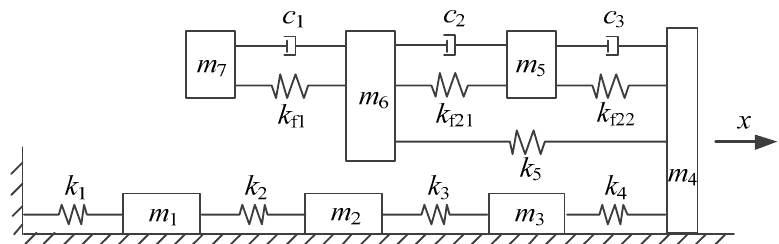
Figure 5. Dynamic model of the fire-fighting jet system with the adaptive gun head.